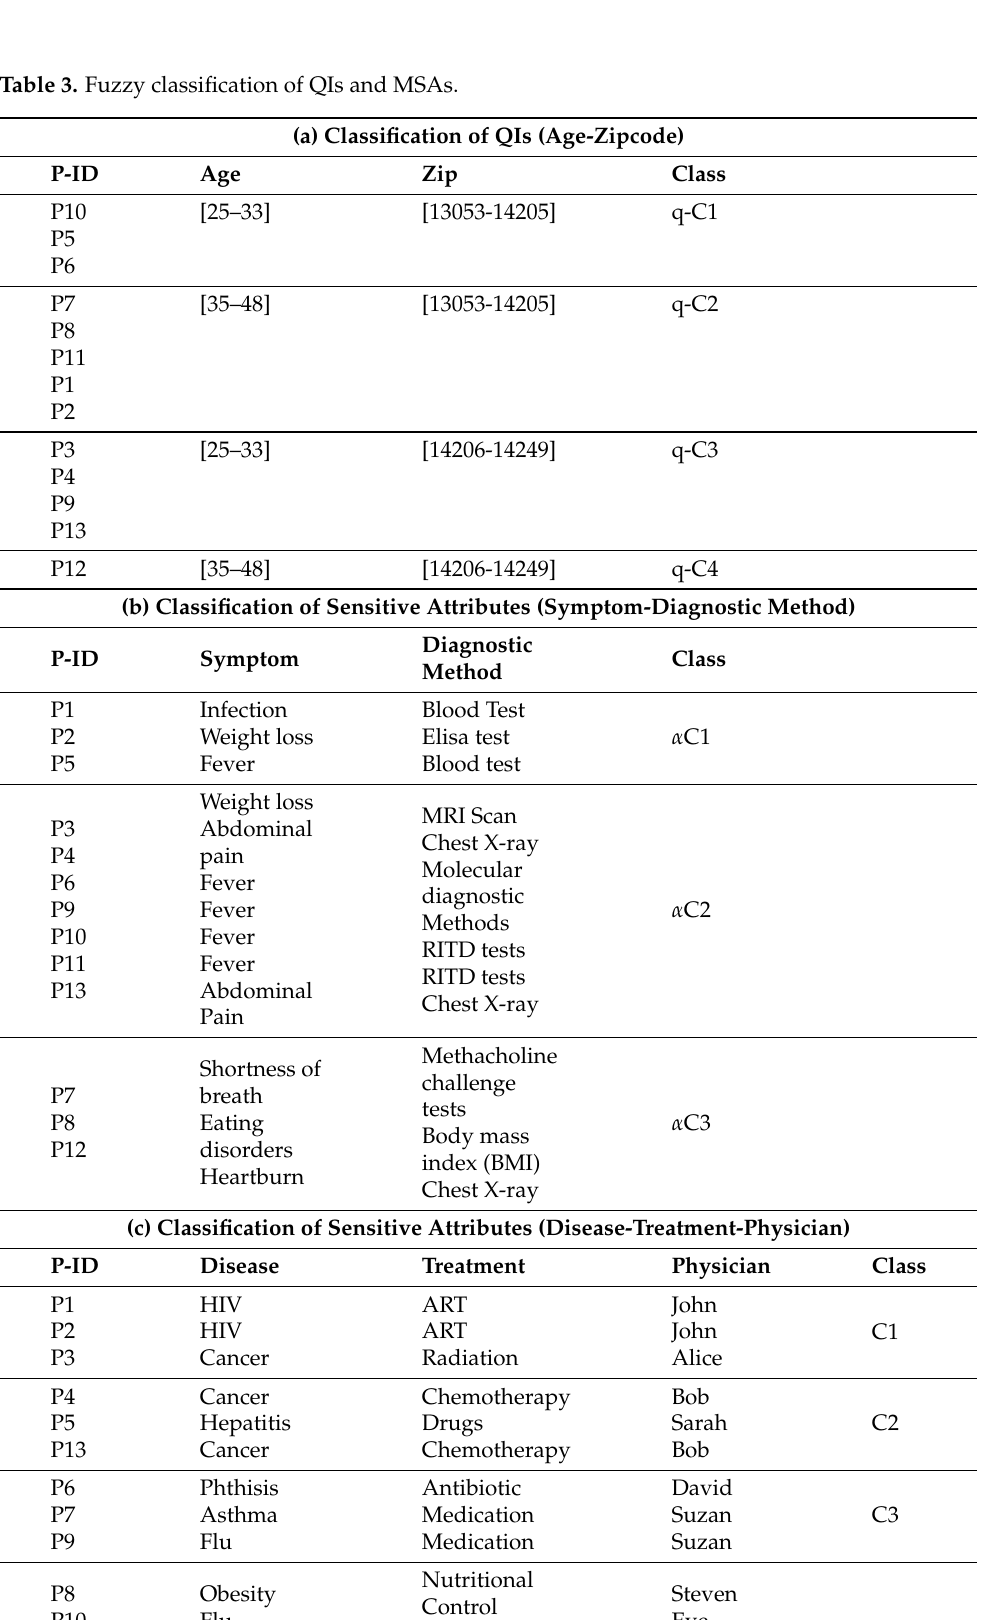
Table 3. Fuzzy classification of QIs and MSAs. (a) Classification of QIs (Age-Zipcode)